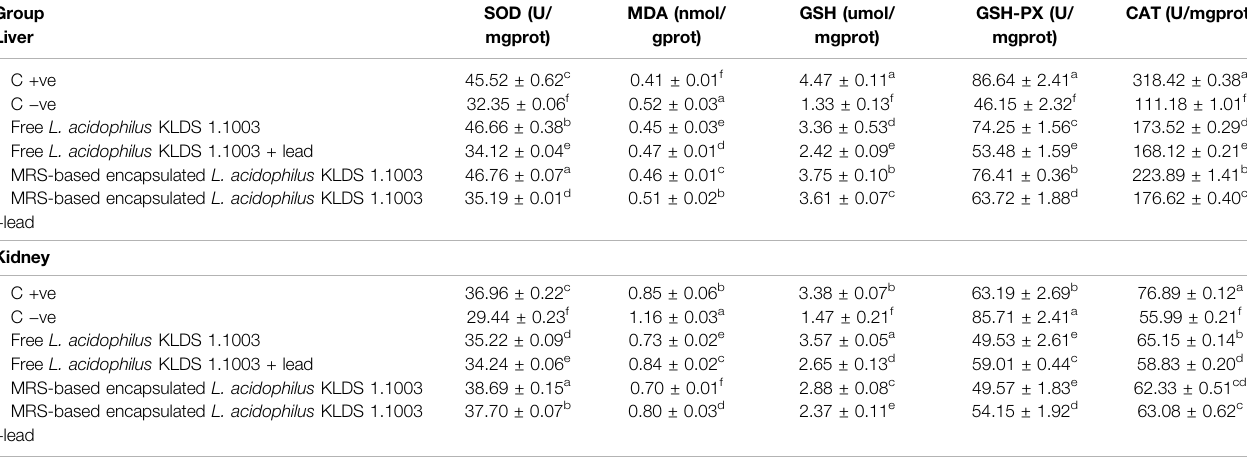
TABLE5| EffectsoffreeandMRS-basedencapsulated L.acidophilus 1.1003onoxidativestressinducedbychronicPbexposure,differencesofantioxidantcapabilityinthe kidney and liver. Group Liver